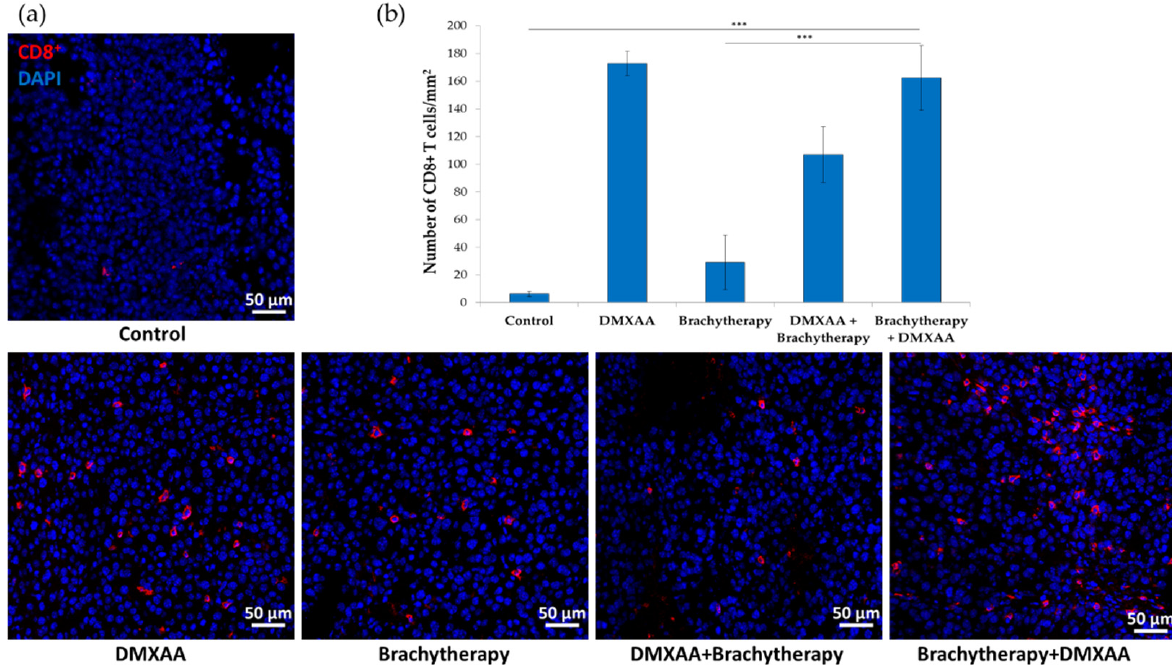
Figure 5. Effect of combination therapy on infiltration of tumors by CD8 + T lymphocytes. Twenty days after tumor inoculation tumors were collected. ( a ) Tumor sections were stained with anti-CD8 antibody. CD8 positive T lymphocytes (Alexa Fluor 594, red) and nuclei (DAPI, blue) were visualized using confocal microscope. Photographs were taken in 5 randomly chosen fields (magn. 20 × ) per section in at least 4 tumors of each group. Representative photographs are shown. ( b ) Total number of CD8 positive cells was calculated per mm 2 of tumor section (mean ± SEM) *** p < 0.001 Kruskal–Wallis multiple comparisons.